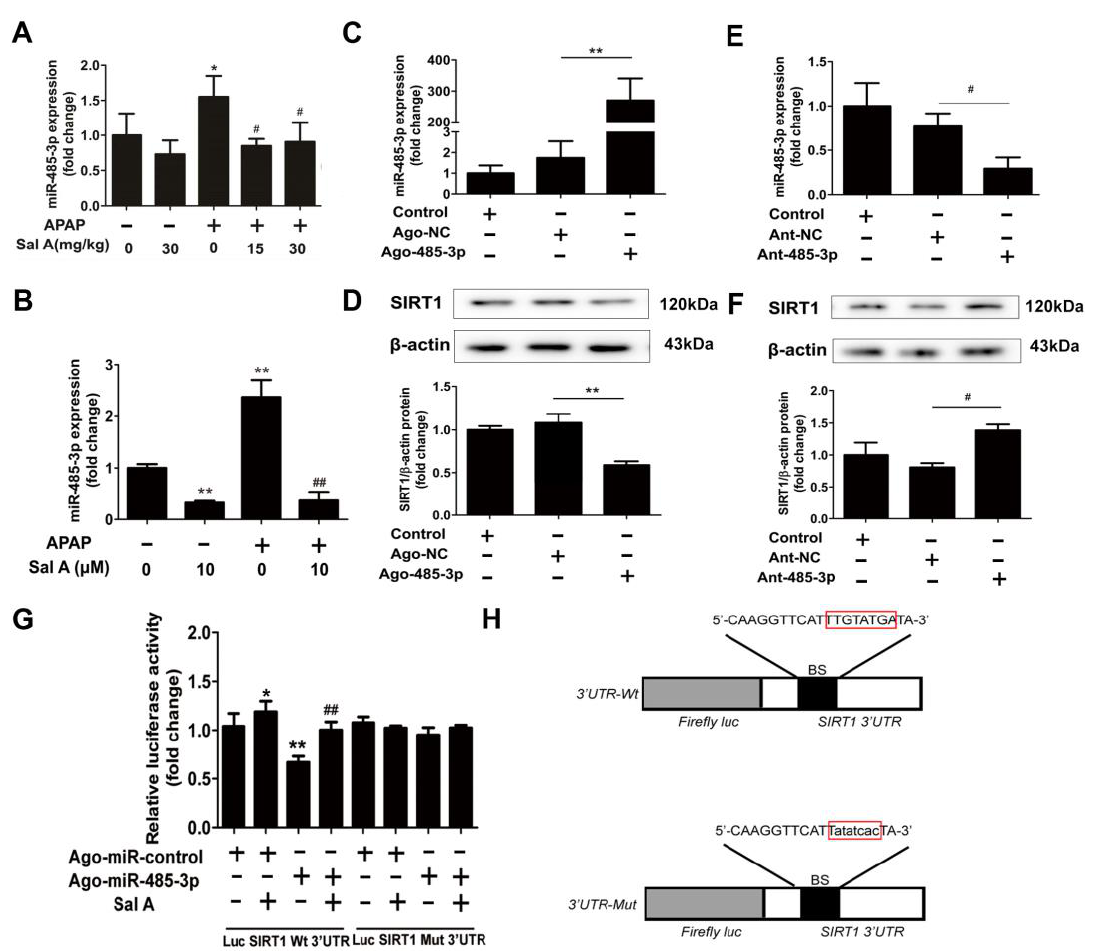
Figure 5. miR-485-3p regulates SIRT1 expression in AML12 cells. ( A ) Sal A pretreatment was performed for 3 days followed by APAP stimulation in mice. miR-485-3p expression in mice, n = 3. ( B ) AML12 cells were incubated with Sal A before exposure to APAP. miR-485-3p expression in AML12 cells, n = 3. ( C – F ) Ago-485-3p, ant-485-3p or negative control was transfected into AML12 cells. ( C , E ) miR-485-3p expression, n = 3. ( D , F ) SIRT1 expression, n = 3. ( G ) Dual luciferase assay. Luciferase constructs containing wild-type or mutant SIRT1-3′-UTR and ago-485-3p or negative control were cotransfected into AML12 cells followed by Sal A treatment, n = 3. ( H ) Luciferase constructs with 3′UTR-wt or 3′UTR-mut of SIRT1. BS, binding site. * p < 0.05, ** p < 0.01 vs. control, ago-NC or ant-